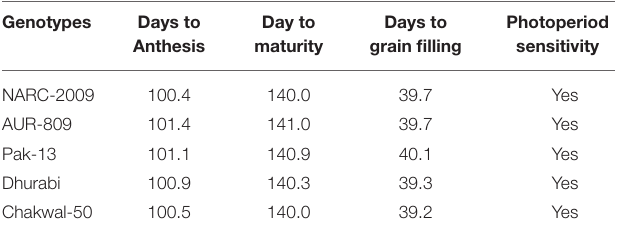
TABLE 3 | Phenological characteristics of five wheat genotypes used in this study.